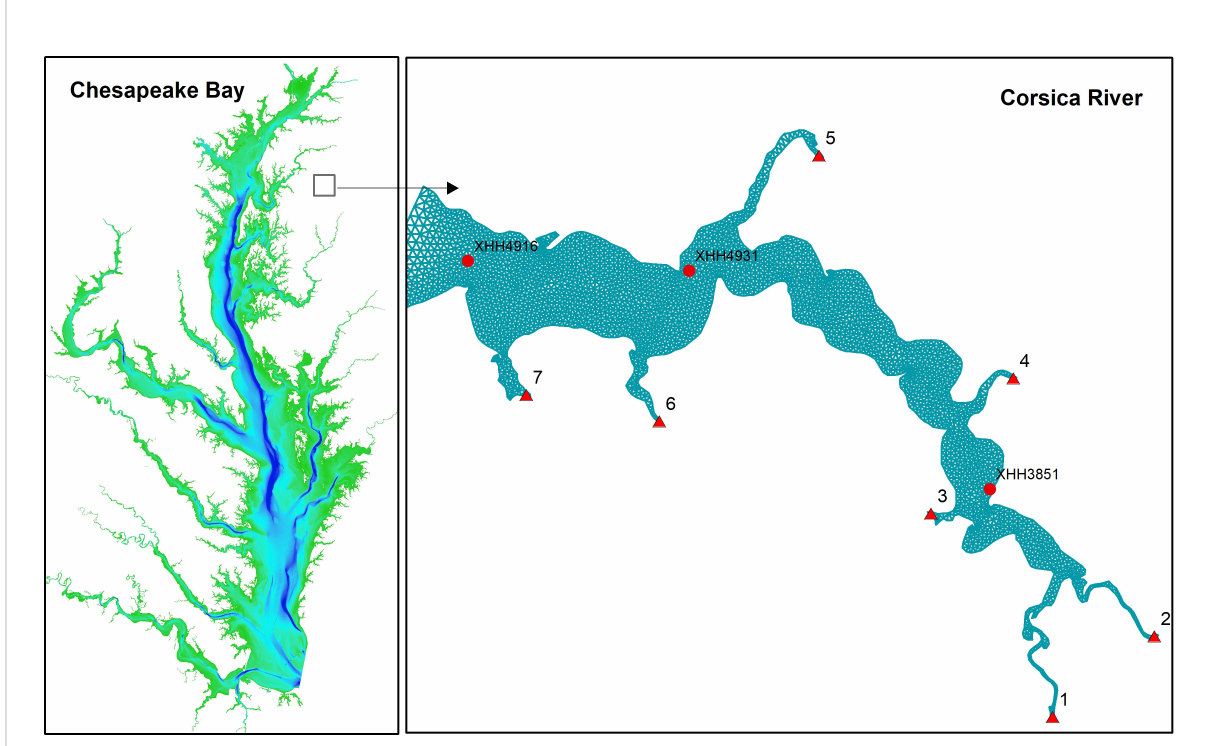
FIGURE 1 Geographic location of the simulation domain and grid. Background color of the left panel is the bathymetry ranging up to 40 m (blue). Red triangles on the right panel are the seven freshwater discharge locations from the watershed. Red dots are the four stations with both cruise- based sample data and sensor-based continuous monitoring